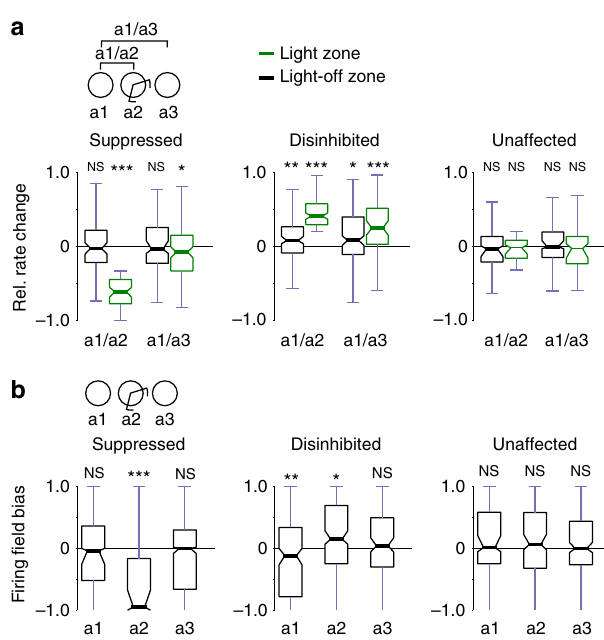
Figure 4 | Disinhibition of CA1 place cell activity leads to persistent increase in firing rate. ( a ) Relative firing rate changes between exploration sessions for light zone (green) and outside (black). Binomial test, separately for light zone (ON) and outside (OFF). Suppressed cells: a1/a2, OFF: P ¼ 0.8358, ON: *** P o 0.0000001; a1/a3, OFF: P ¼ 0.4069, ON: